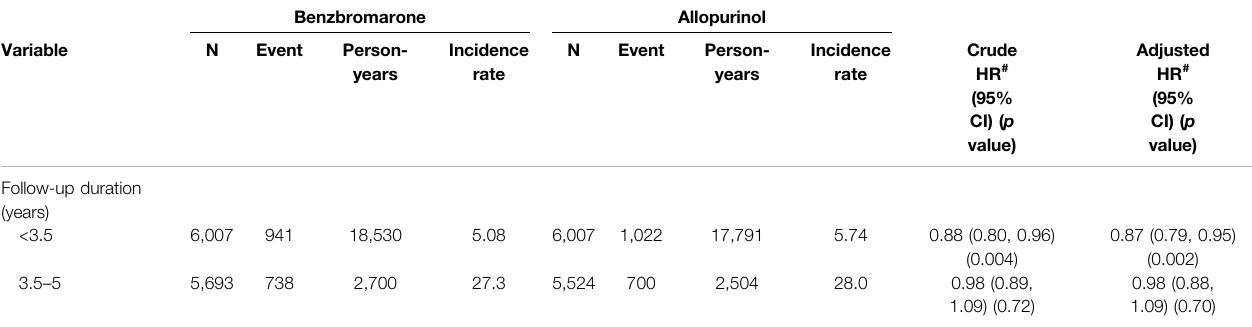
TABLE 2 | Incidence density of type 2 diabetes mellitus between benzbromarone use group and allopurinol use group. Benzbromarone